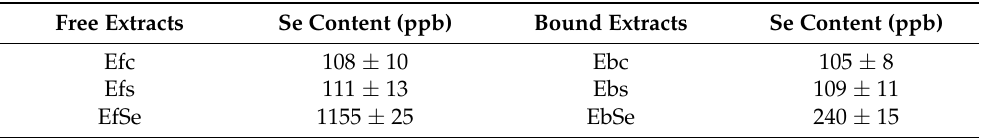
Table 1. Total selenium content in the free and bound extracts of emmer wheatgrass grown with distilled water as a control (Ef c ), or in the presence of salinity as NaCl 50 mM (Ef s ) or selenium as 45 mg L − 1 of Na 2 SeO 3 (Ef Se ). All analyses were performed in triplicate. Free Extracts Se Content (ppb) Bound Extracts Se Content (ppb) Efc 108 ± 10 Ebc 105 ± 8 Efs 111 ± 13 EfSe 1155 ±